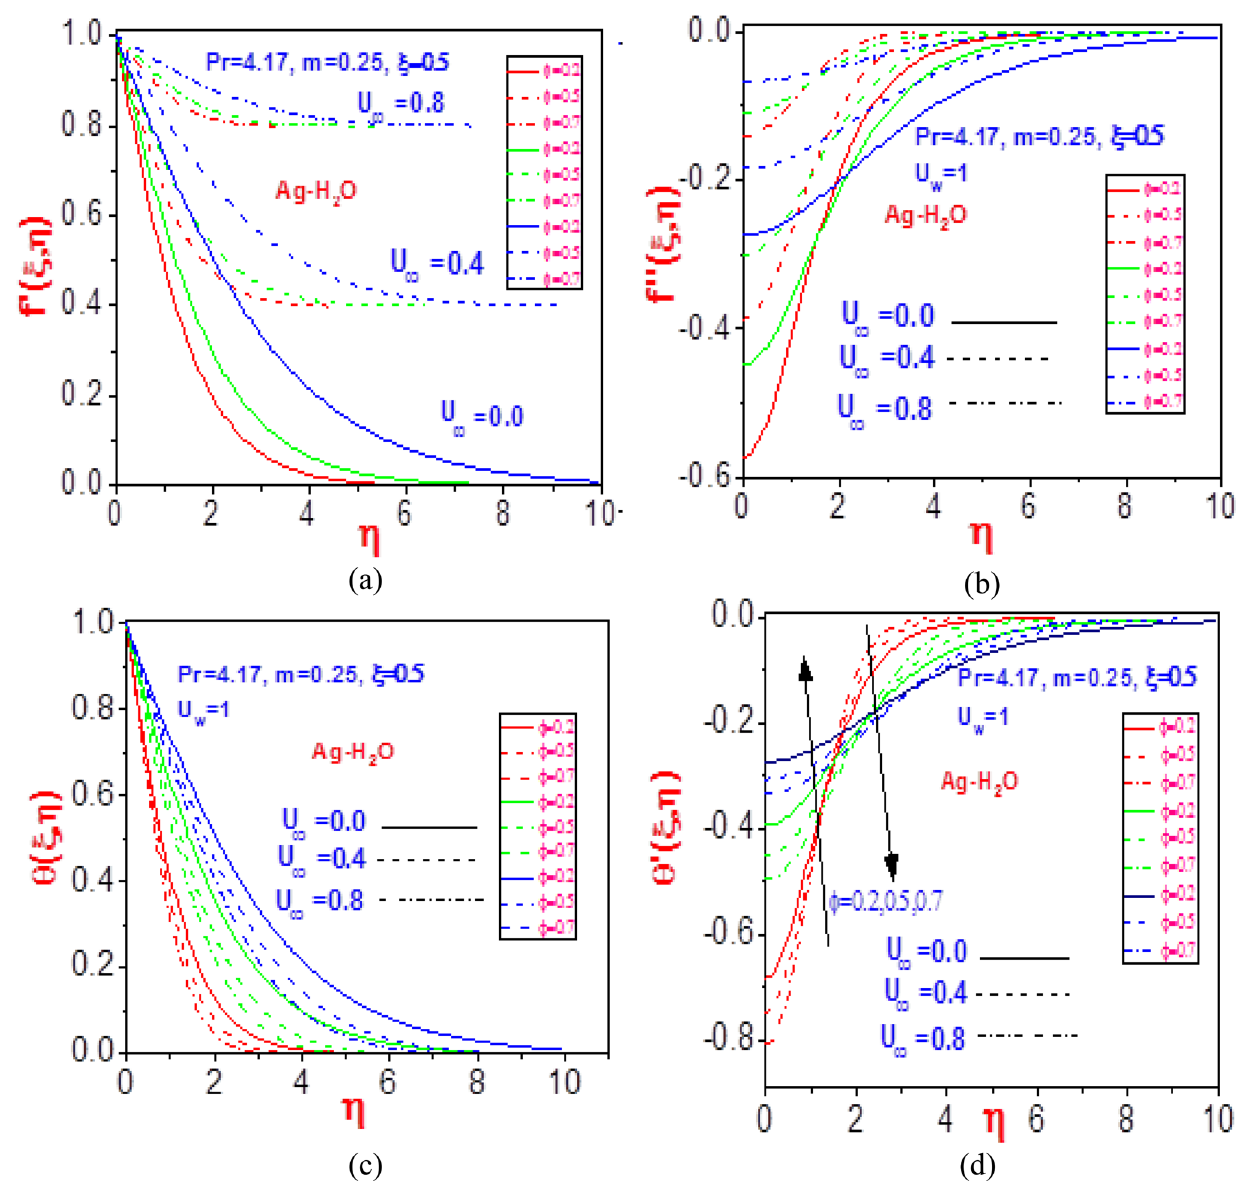
Figure 6. Profiles of ( a ) velocity f ′ (ξ , η) , ( b ) missing velocity slope f ′′ (ξ , η) , ( c ) temperature θ(ξ , η) , and ( d ) missing temperature slope θ ′ (ξ , η) with different values of U ∞ and φ for Ag-H 2